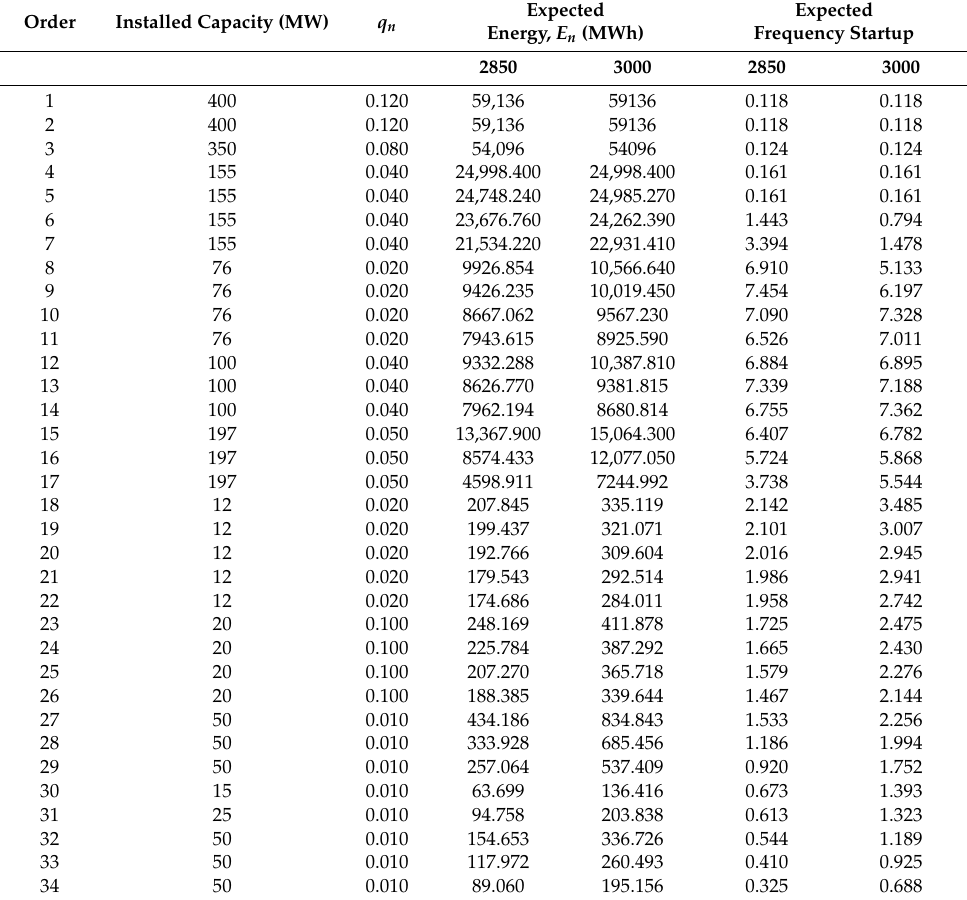
Table 1. The results of the base case for all generating units based on peak loads of 2850 and 3000 MW for the modified IEEE